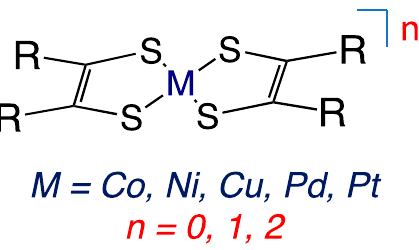
Figure 2. Square planer metallodithiolene complexes. R = CN, CH 3 , Ph, CF 3 .